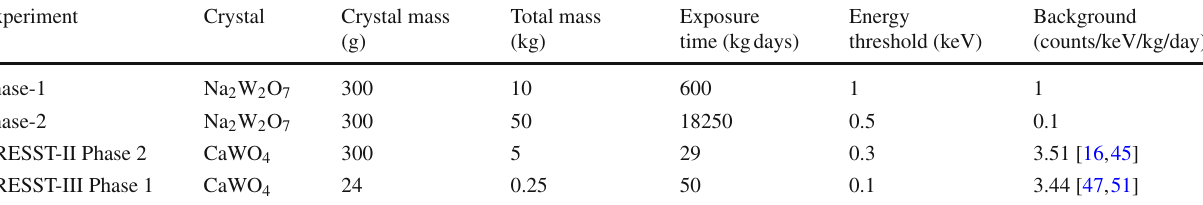
Commons license, and indicate if changes were made. Funded by SCOAP 3